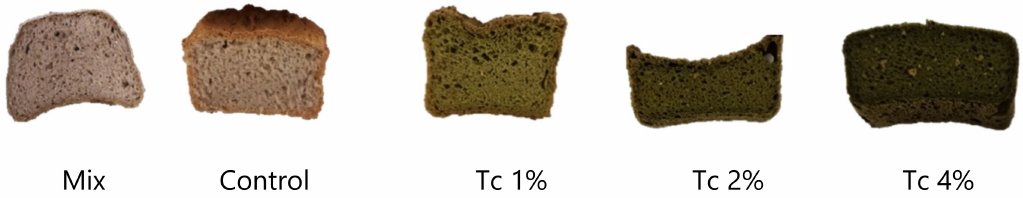
Figure 3. General aspect of the GF breads prepared with commercial mix, control and 1, 2 and 4% ( w / w ) T. chuii gluten free